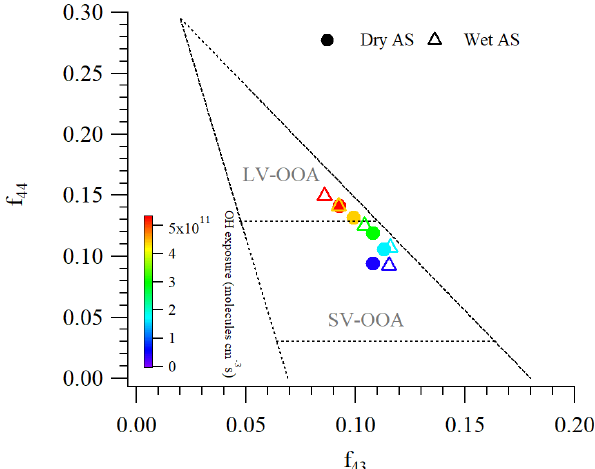
Figure 5. Fractions of total organic signal at m/z 43 ( f 43 ) vs. m/z 44 ( f 44 ) from SOA data obtained in this study together with the triangle plot of Ng et al. (2010). Ambient SV–OOA and LV–OOA regions are adapted from Ng et al. (2010). Data are col- ored according to the OH